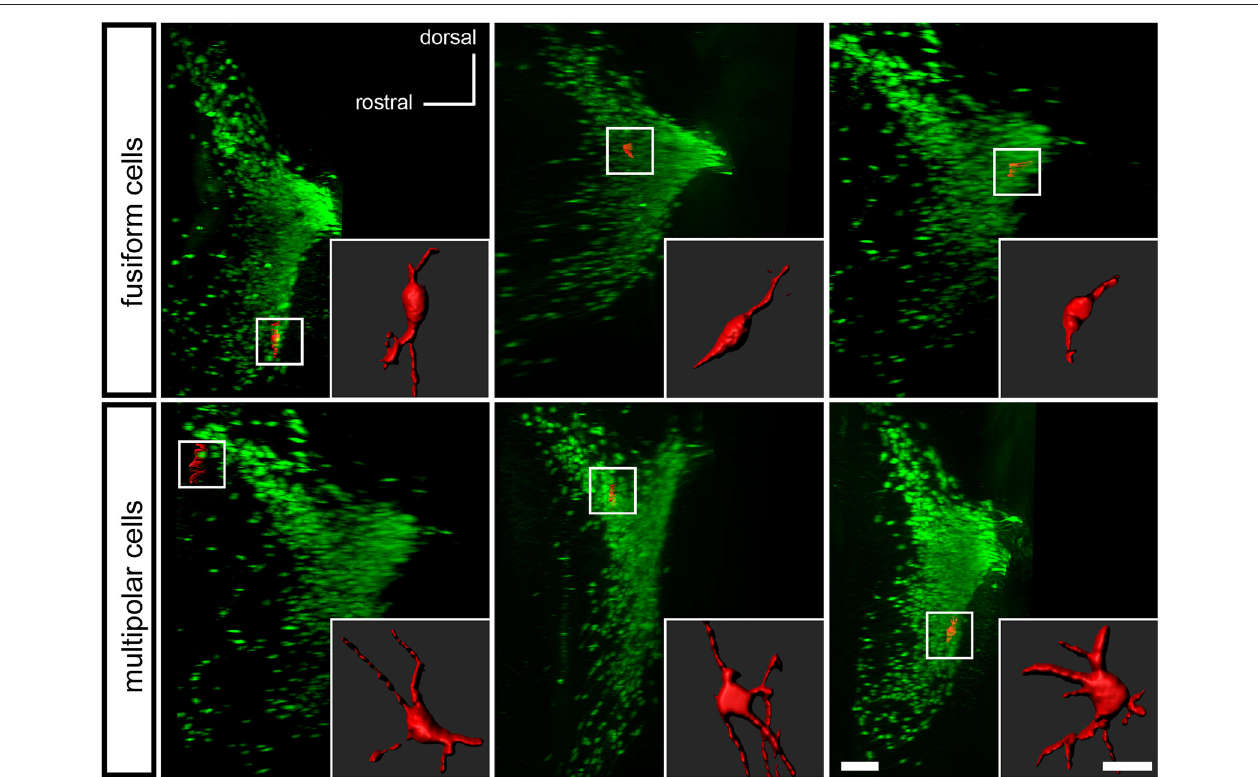
FIGURE 5 | Morphology of Pax7 Cre -negative noradrenergic neurons in the LC complex. In the PACT-cleared LC complex of 4–5-month old mice, the Pax7 Cre -negative noradrenergic neurons are fusiform, generally with one or more processes at each end of the long axis (top) , or multipolar (bottom) . A surface rendering of each neuron shown in coronal view is inset on a sagittal view of the LC complex indicating the location of the neuron. Scale bar: 200 µ m (LC), 40 µ m (individual cells).